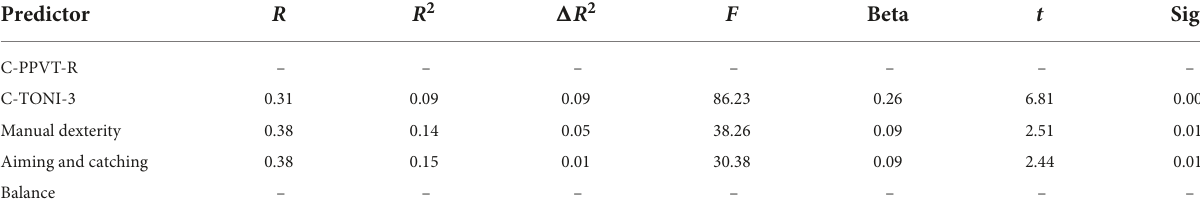
Aiming and catching